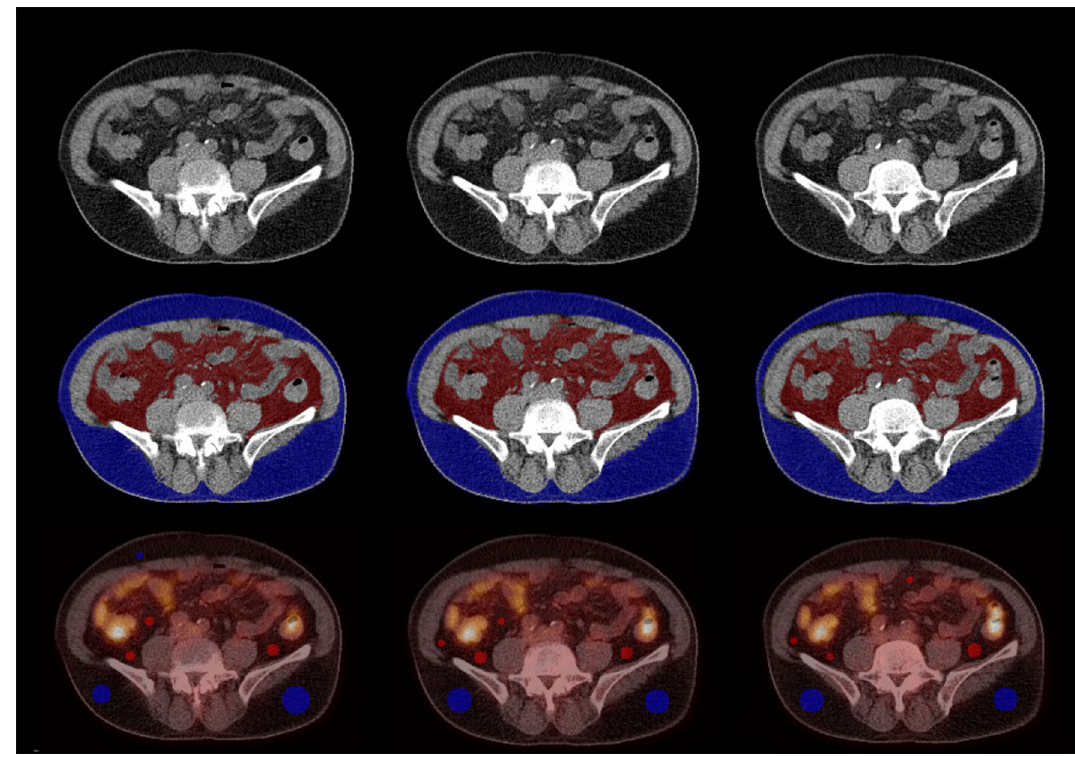
Figure 1. Example of measurement of the volume and standardized uptake value of visceral and subcutaneous tissue from PET/CT images. On the three consecutive trans-axial CT images at the level of L4/5 (top row), the volume of VAT (red) and SAT (blue) were automatically delineated using CT-attenuation range between − 190 and − 30 HU (middle row). On fused PET/CT images, circular ROIs were manually placed on the VAT area while avoiding the spillover from adjacent structures (bottom row). Similarly, circular ROIs were placed on the SAT area (bottom